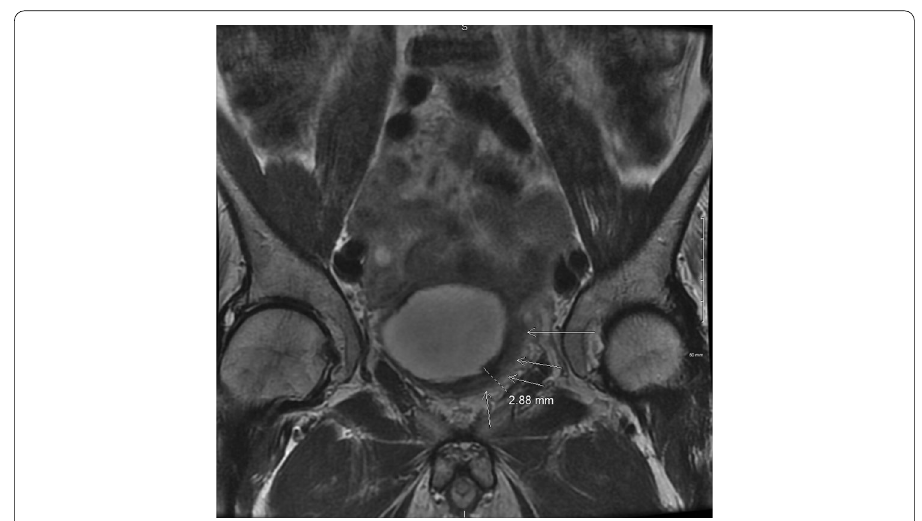
Fig. 2 T2-weighted MRI images showed nonspecific irregular thickening of the left lateral bladder wall